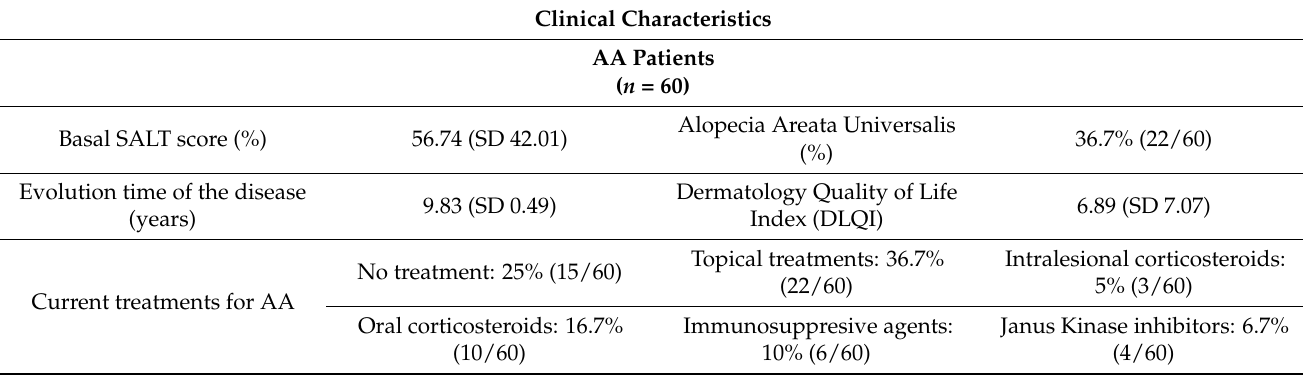
Table 1. Clinical characteristics of the patients suffering from AA.